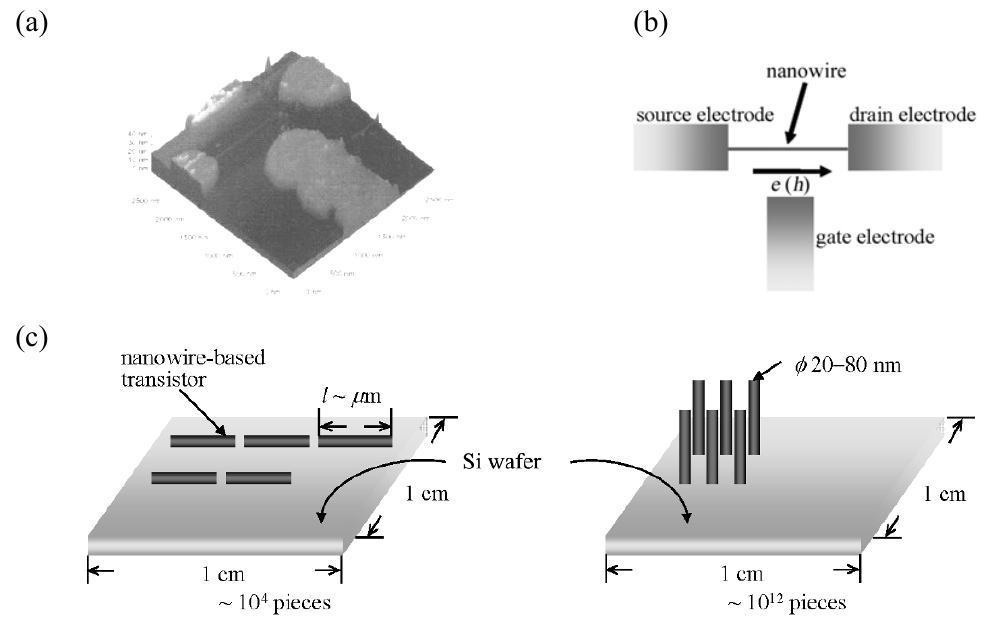
Figure 1. (a) A SEM image of a nano-size transistor fabricated on silicon wafer (b) a schematic diagram, and (c) arrangement of nanowires parallel and perpendicular to a silicon wafer substrate with an area of 1 × 1 cm 2